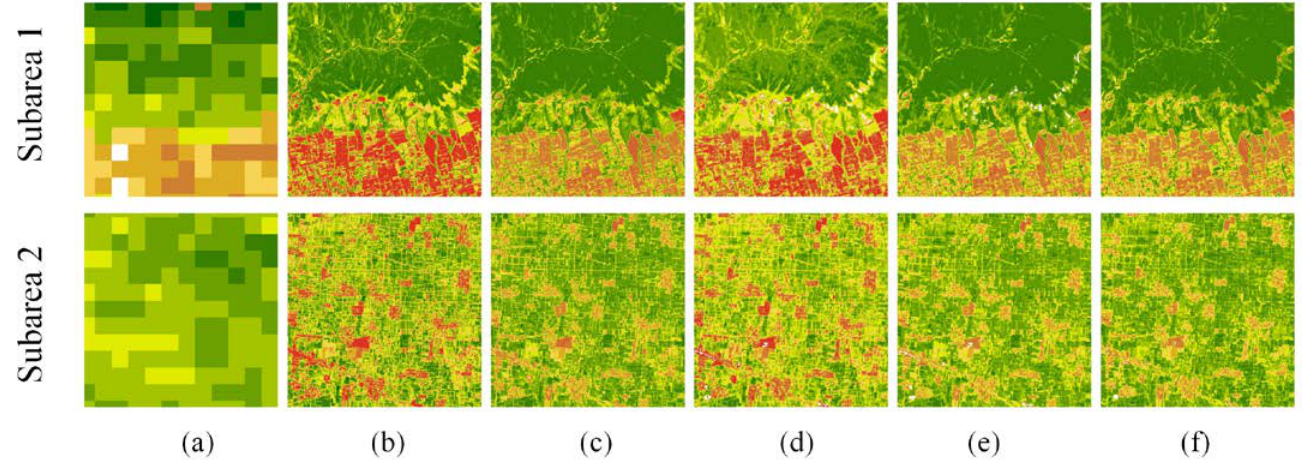
Figure 5. Comparison of MODIS FPAR and Sentinel FPAR images retrieved by SNAP and the scaling-based method in the subarea area on 1 August 2021. ( a ) MODIS FPAR. ( b ) SNAP FPAR at 10 m. ( c ) Scaled FPAR with three bands. ( d ) SNAP FPAR at 20 m. ( e ) Scaled FPAR with five bands. ( f ) Scaled FPAR with eight bands.